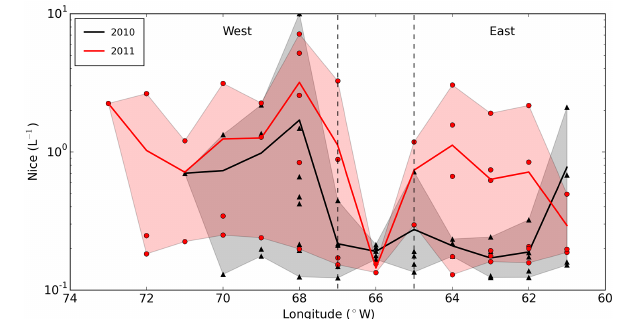
Figure 8. Same as Fig. 4 but for the number concentration of ice crystals (L − 1